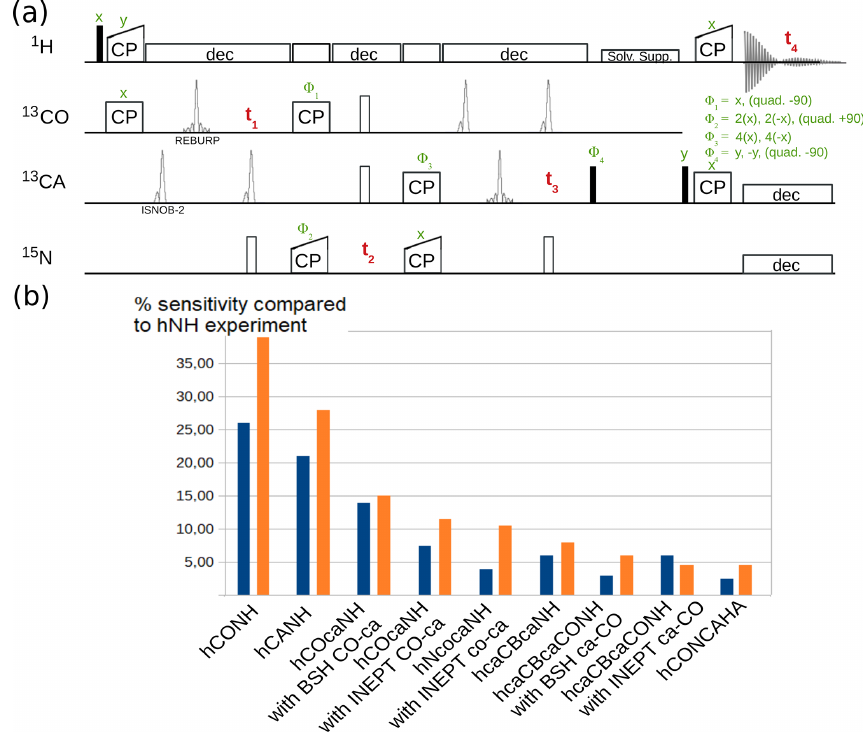
Figure 7. (a) 4D hCONCAHA pulse sequence for H α -detected backbone correlation, using cross-polarization transfer steps. Filled and open bars denote π/ 2 and π pulses, respectively. Homonuclear 13 C − 13 C decoupling is achieved with band-selective ISNOB2 pulses; Bloch– Siegert shift effects are compensated. Solvent suppression follows the ideas of the MISSISSIPPI scheme (Zhou and Rienstra, 2008) but unlike the original proposition uses a composite-pulse-decoupling scheme for saturating the solvent signals while storing the magnetization on the heteronucleus (+C z ). Quadrature detection is achieved with phases (cid:56) 1 , (cid:56) 2 and (cid:56) 4 , whereby the phase is changed by either + 90 or − 90 ◦ , as indicated. (b) Sensitivity comparison of diverse pulse programs with a tube-like protein assembly formed by 50kDa large subunits (Fraga et al., 2017) and decameric assembly of 10 × 21kDa, in orange and blue, respectively. The data were obtained by integration of 1D variants of the pulse